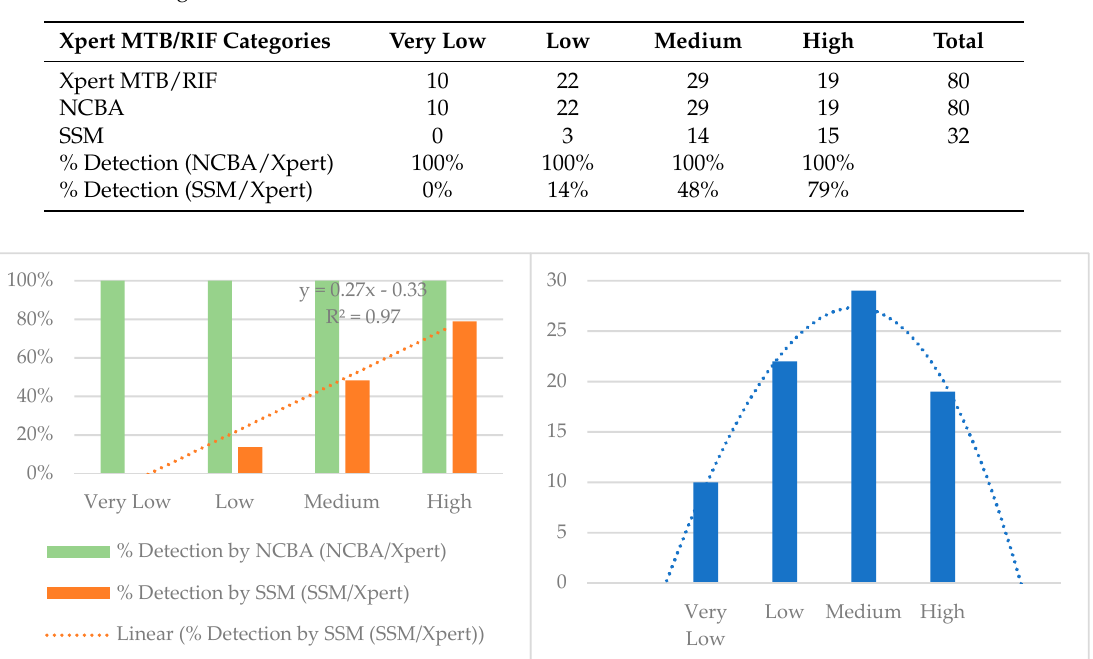
Table 3. Detection limit and dynamic range of detection of the two techniques with respect to the Xpert MTB/RIF categories.